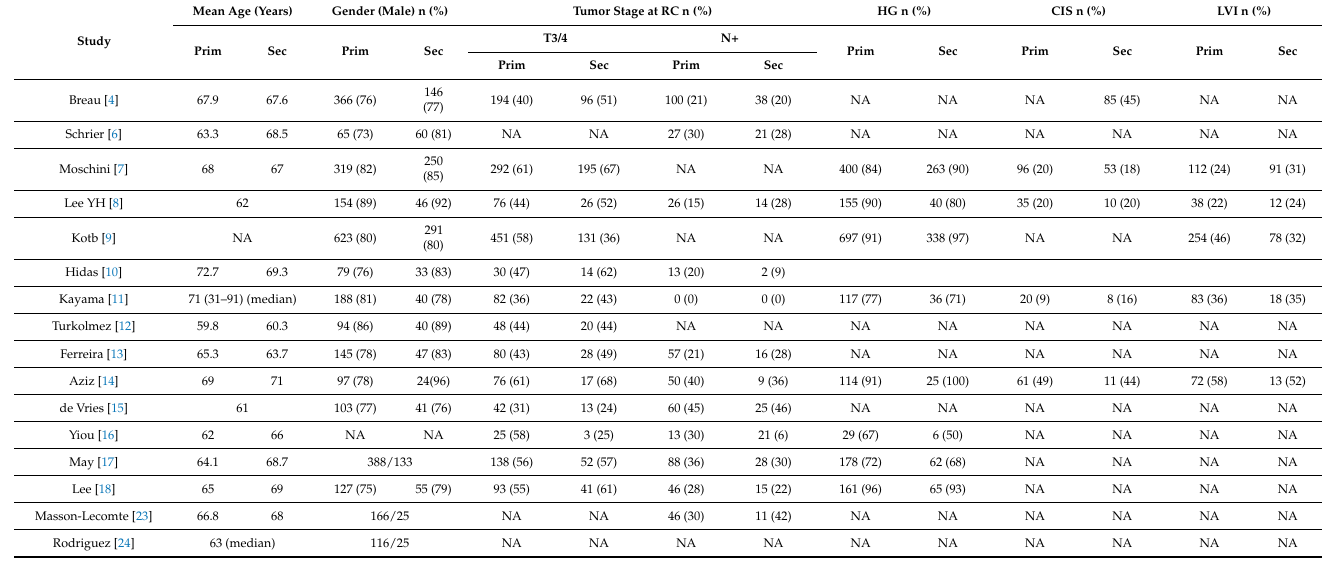
Table 2. Characteristics of included patients.